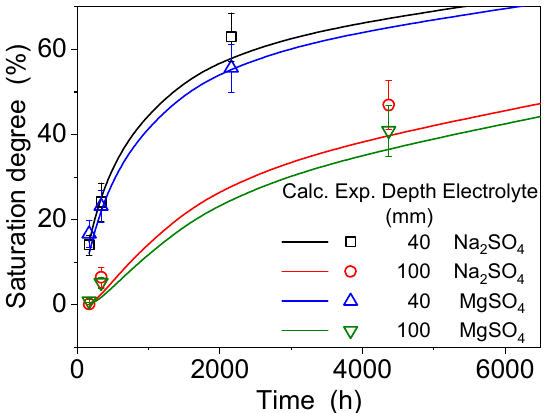
Figure 6. Local concentrations of solute at different times and locations in the dissolution and diffusion processes of bloedite; the experimental data after 2000 h are the test results in the salt pond of Yuncheng Salt Lake, China.